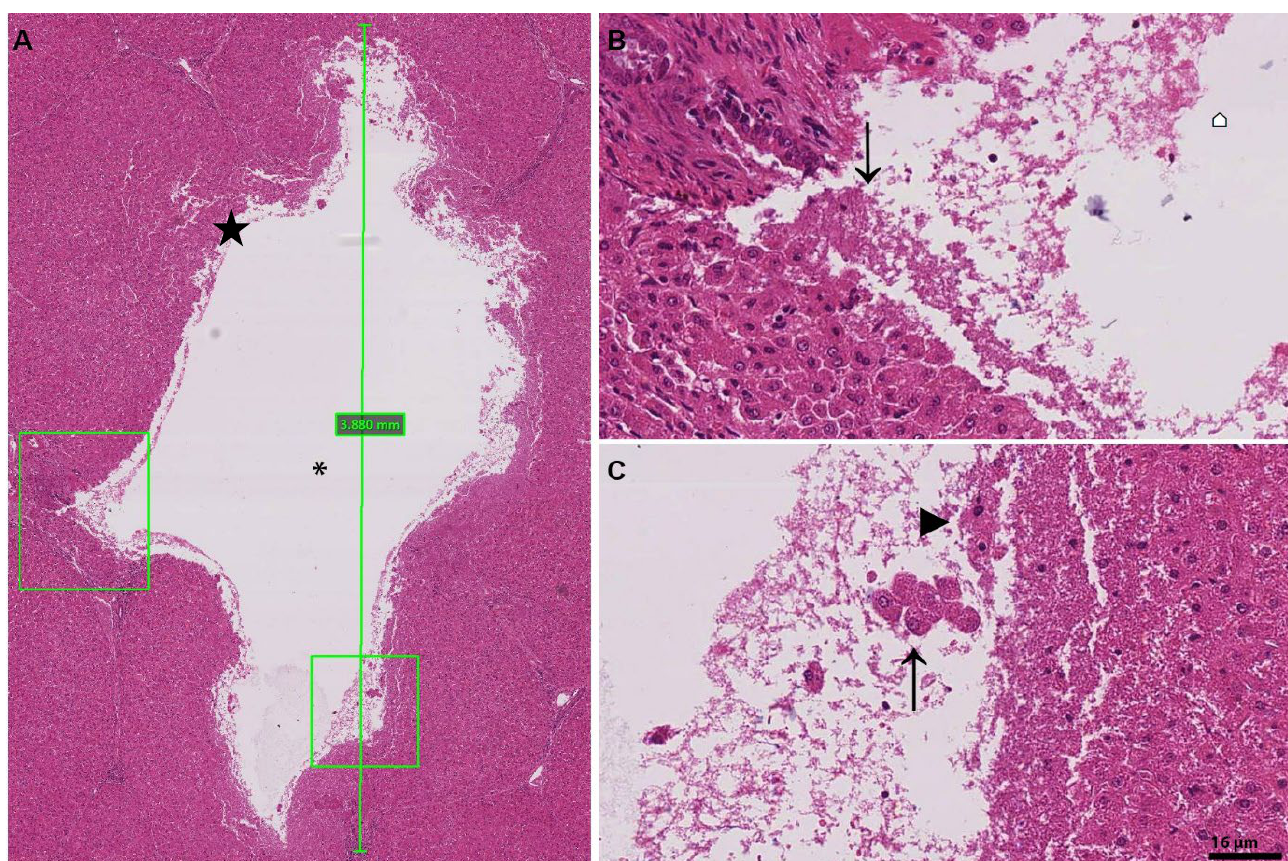
Figure 3. H&E cross-section staining of the HIFU histotripsy lesion. ( A ) Example of a lesion with its core suspension aspirated for analysis. The * marks the aspirated core of lesion where cell suspension would have been and HIFU creates a cavity of about 3.8 mm in size. The two square areas are zoomed in, the left box corresponding to ( B ) and the right box to ( C ), which show intact hepatocytes detached by the force of histotripsy. The force generated is focused and the adjacent cellular and extracellular components are preserved. ( B ) Reveals the impact of the histotripsy force, resulting in finely fragmented cells ( ⌂ ) and causing mechanical disturbance of adjacent cells. The arrow marks damage to a nearby vessel. ( C ) The force not only results in destruction of cellular and extracellular components into fine granules, but it can also result in the bursting of the cell membrane ( ► ), whereas other cells escape ( ↑ ) the full impact of the force generated and are either in clusters of intact cells or as individual cells in the core suspension.